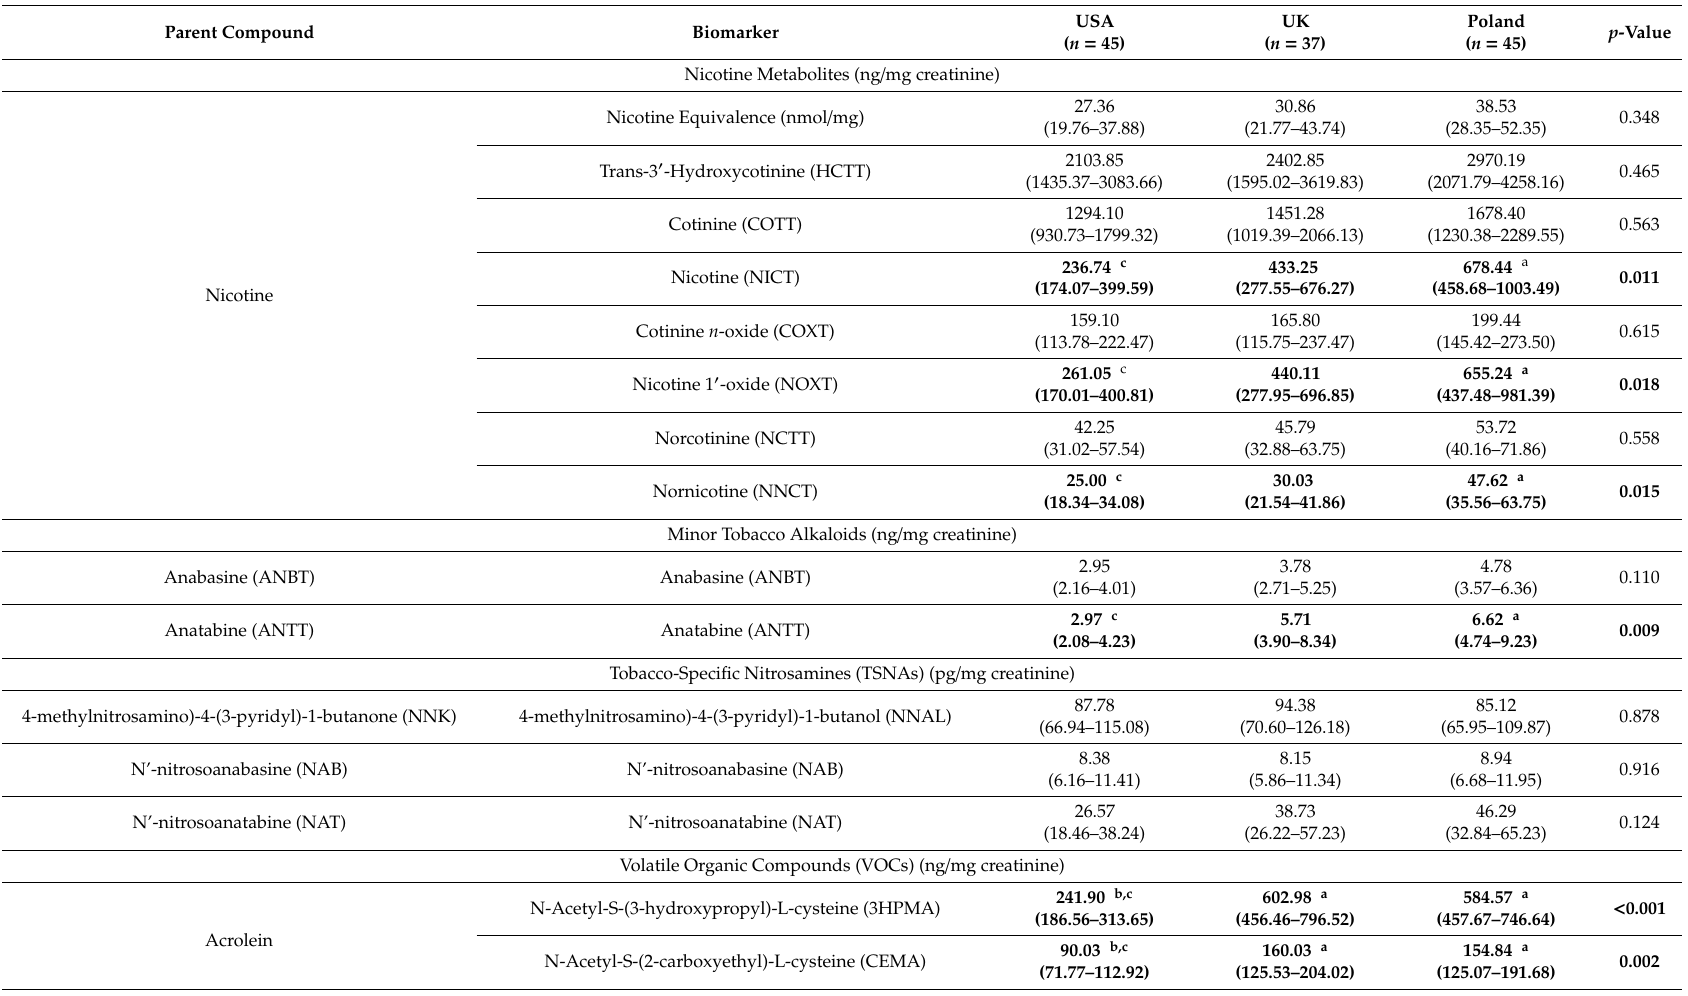
Table 4. Biomarkers of exposure to nicotine and selected toxicants in urine of exclusive smokers ( n = 127) from USA, UK, and Poland (normalized for creatinine; geometric means, 95% confidence